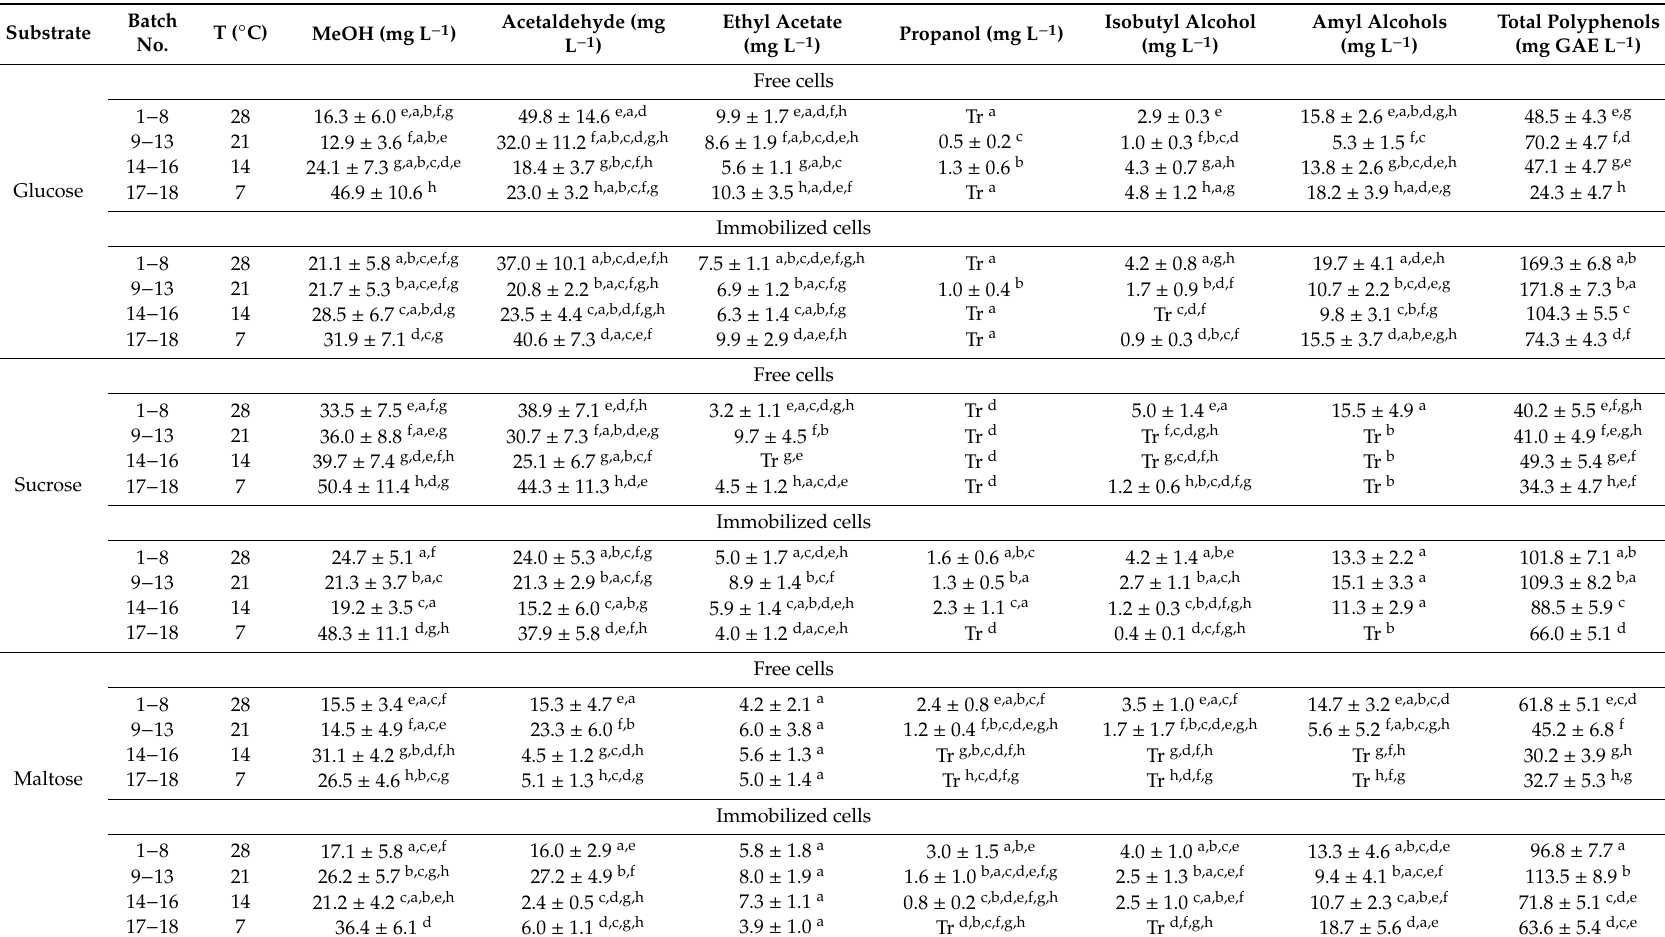
Table 2. The e ff ect of fermentation temperatures on volatile by-products and polyphenols content during successive fermentation batches of synthetic mediums using free or immobilized yeast cells on P. terebinthus